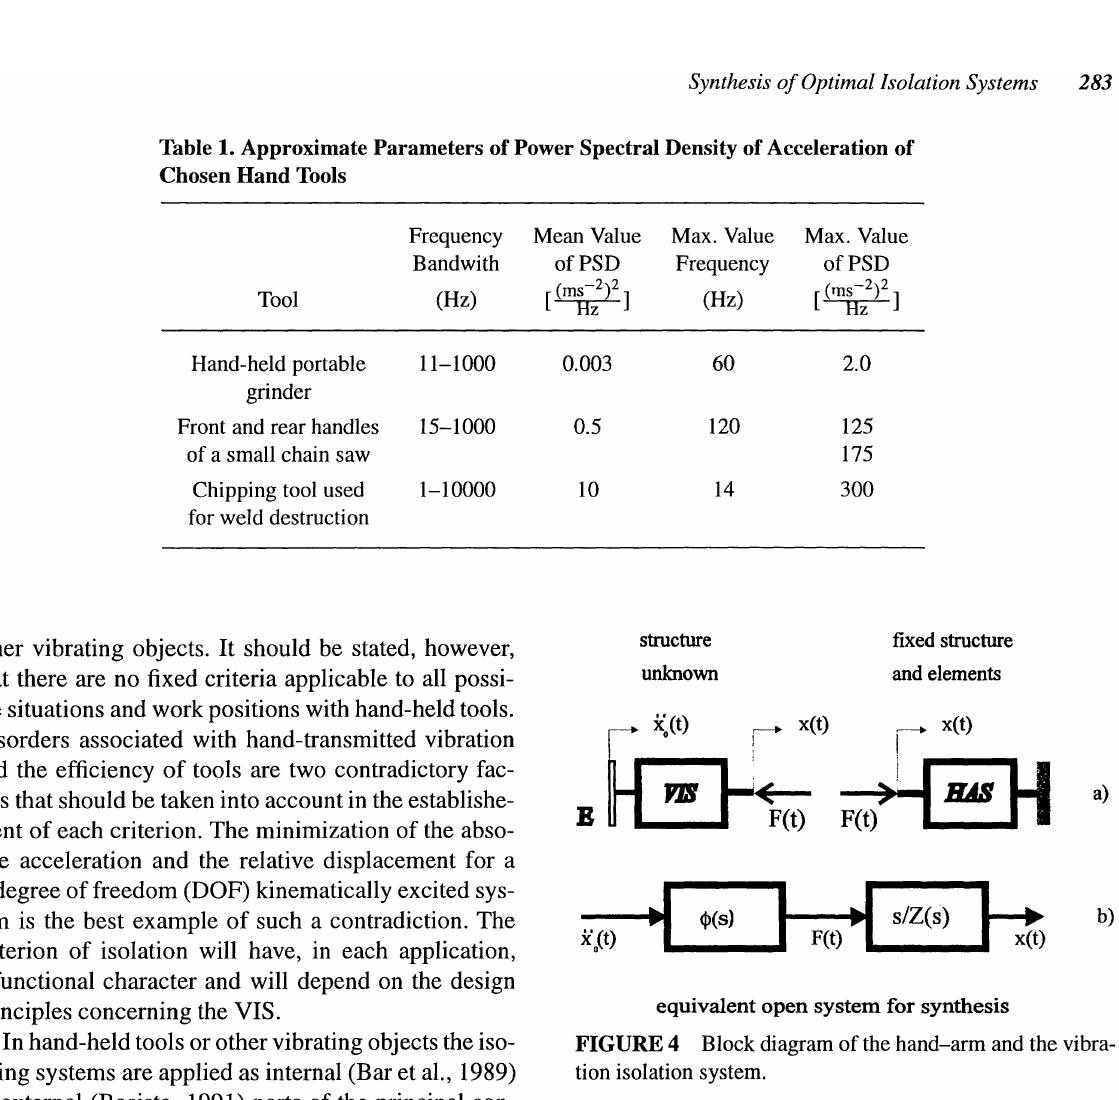
FIGURE 4 Block diagram of the hand-arm and the vibra tion isolation